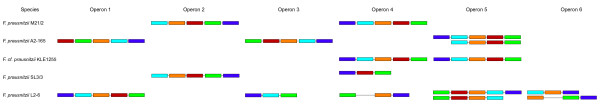
Arrangement of peptides/nickel transporter operons within the five strains of Faecalibacterium prausnitzii. Phylogenetic analysis of sequences associated with the nickel/peptides transporter complex revealed six distinct operons of potentially different origins. Operon constituents are coloured by KO (red = K02031; green = K02032; blue = K02033; orange = K02034; purple = K02035) with operon order according to numbering of genes in IMG chromosome maps.